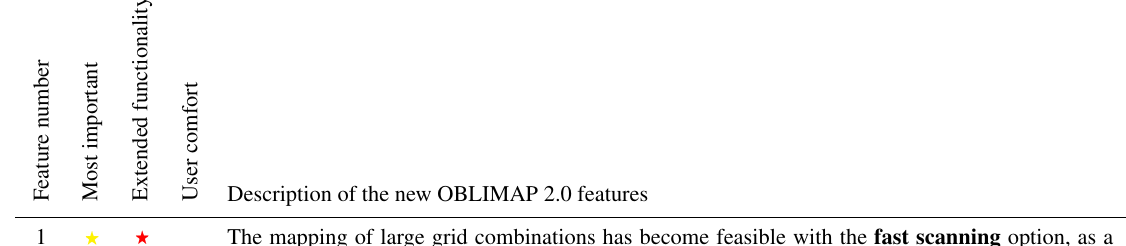
Table 1. Shortlist of the new OBLIMAP 2.0 features and changes. The stars indicate the categories of the new features. For the full list and more details see the OBLIMAP User Guide. The terms in bold are used for short reference to the described